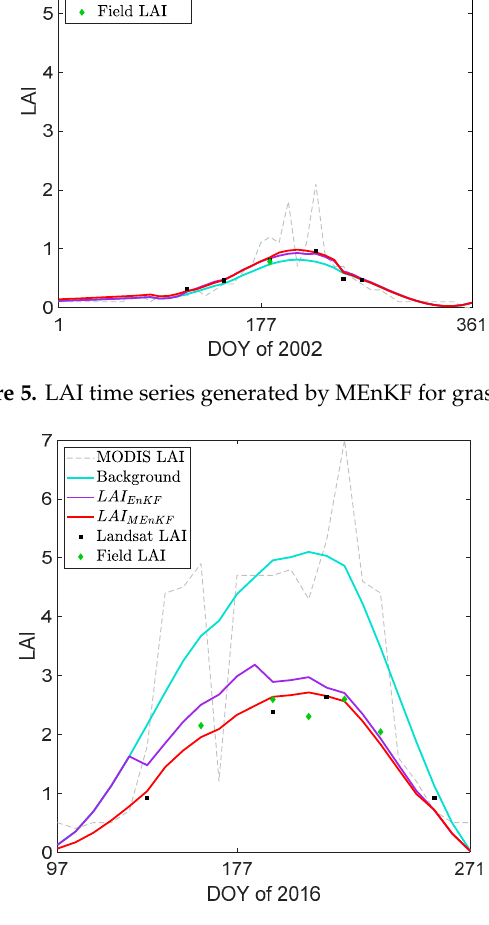
Figure 6. LAI time series generated by MEnKF for woodland.